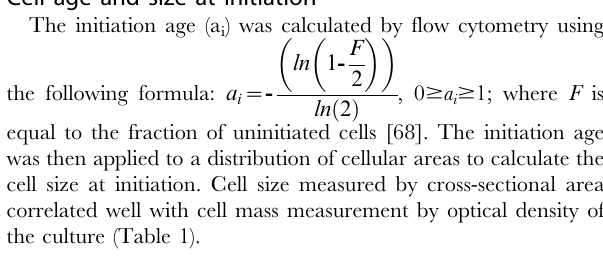
Figure S1 Representative pictures and growth curves of E. coli .